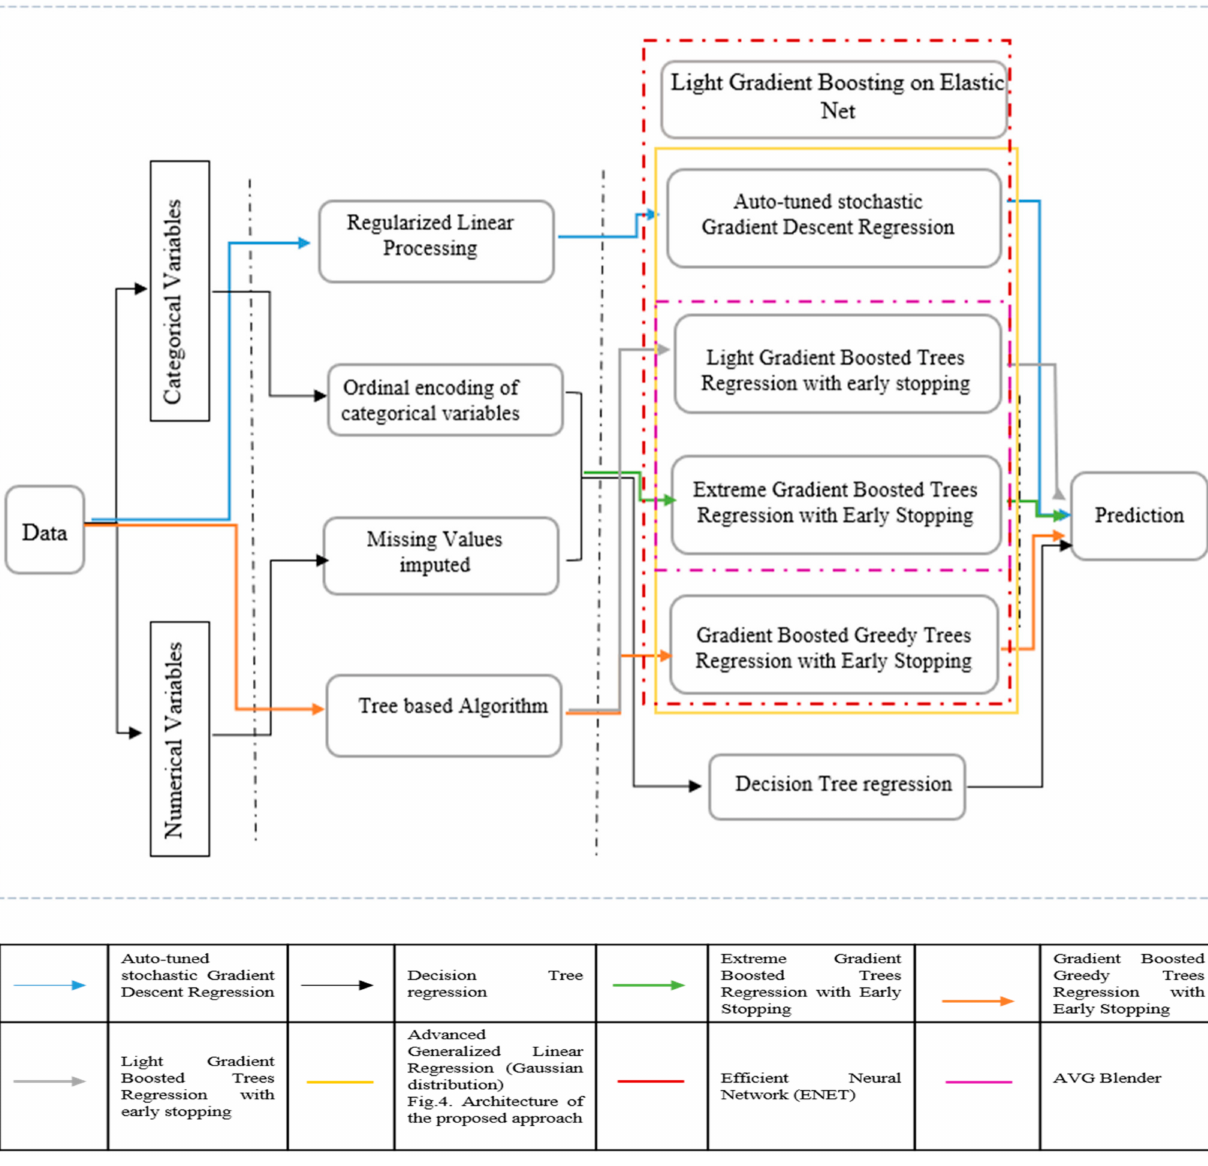
Figure 4. Architecture of the proposed